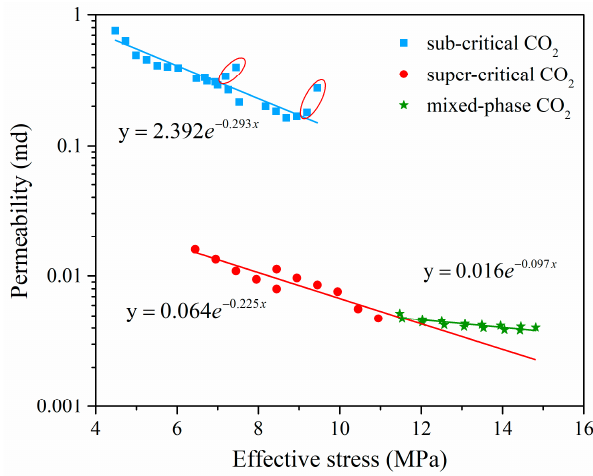
Figure 17. Influence of effective stress on sub-critical, super-critical, and mixed-phase CO 2 permeability.